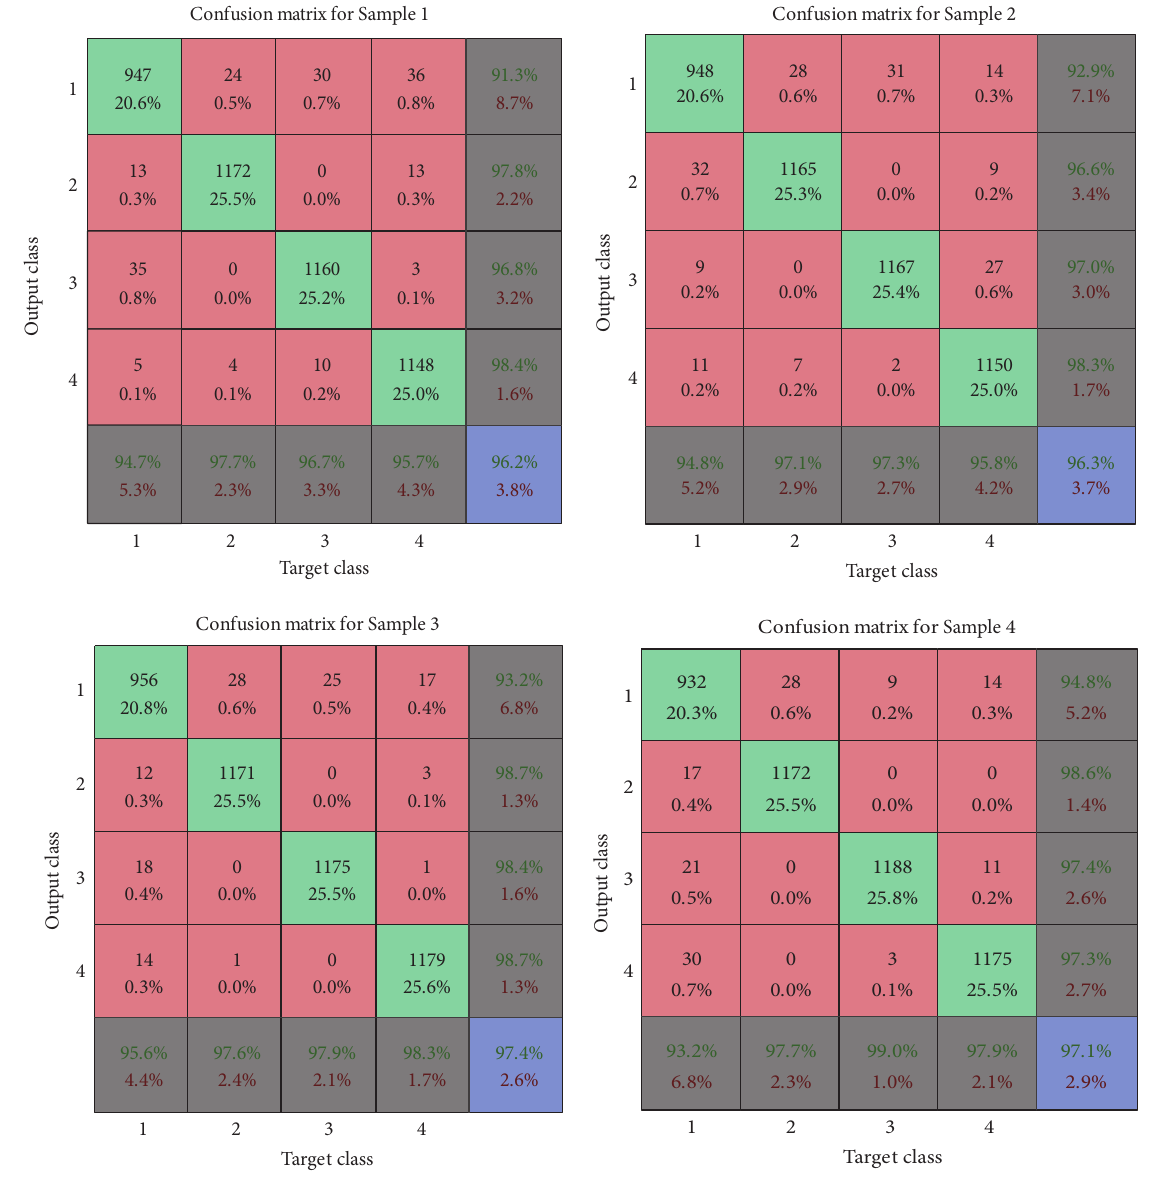
Figure 11: Confusion matrices of four samples of data using targeted and output